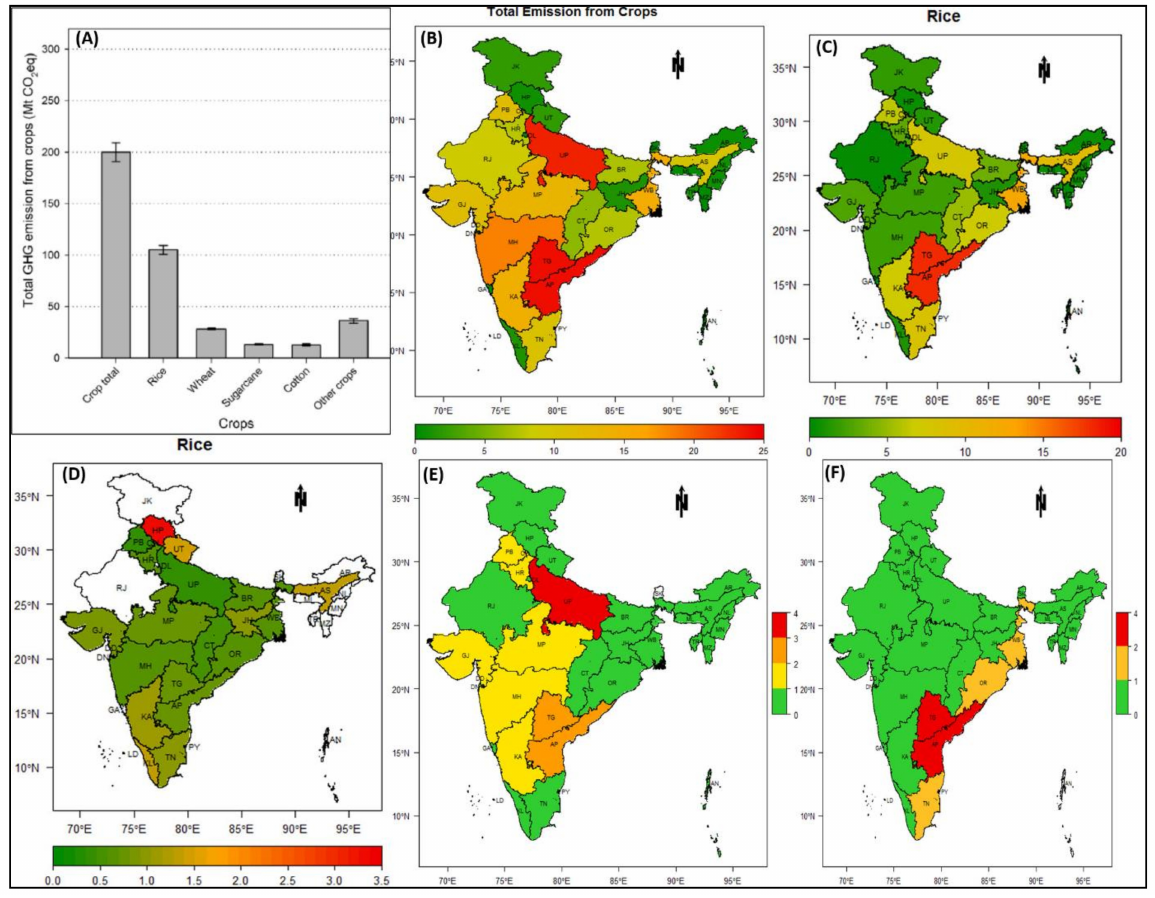
Figure 2. ( A ) Total national GHG emissions from crops. ( B ) State-wise distribution of total GHG emissions (Mt CO 2 e) from crops and ( C ) from rice specifically. ( D ) GHG Emission intensity (kg CO 2 e/kg product) of rice. ( E ) Spatial distribution of GHG mitigation potential (MtCO 2 e per year) through improved fertilizer management and ( F ) through improved water management in rice. Source: Sapkota et al.